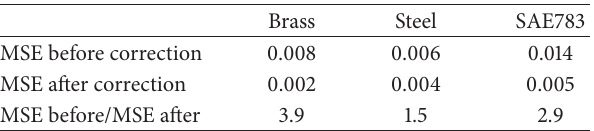
Table 3: Mean square error according to (17) for the brass and steel calibration blocks and the SAE 783